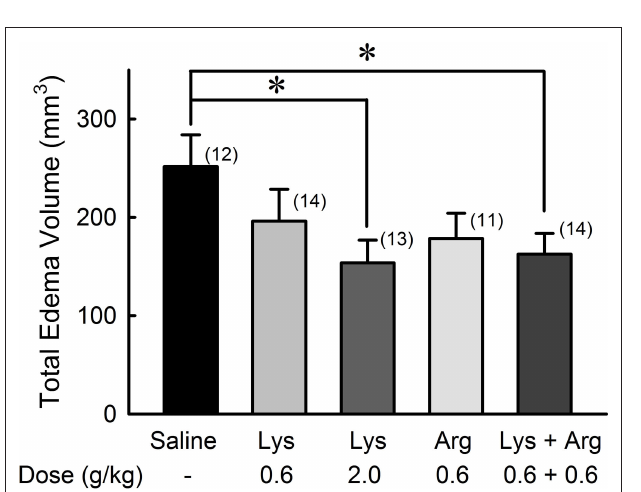
FIgure 3 | effects of lysine (Lys) and/or arginine (Arg) on cortical and striatal edema in MCAO rats. Note that significant reduction of edema volume was observed in the cerebral cortex but not in the striatum by administration of lysine (2.0 g/kg), arginine (0.6 g/kg), or combined administration of lysine and arginine. * p < 0.05, significance compared to the saline-treated control group by ANOVA followed by Fisher’s PLSD